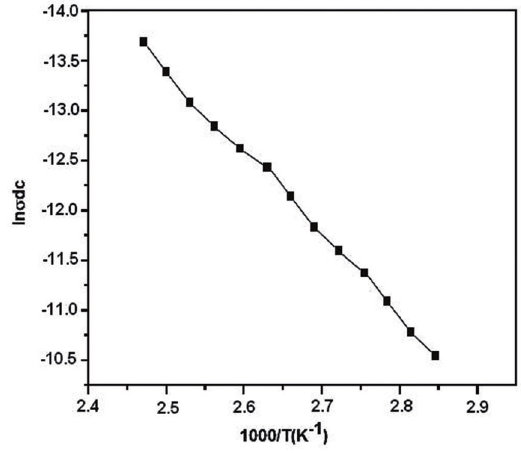
versus 1000/T (K -1 dc